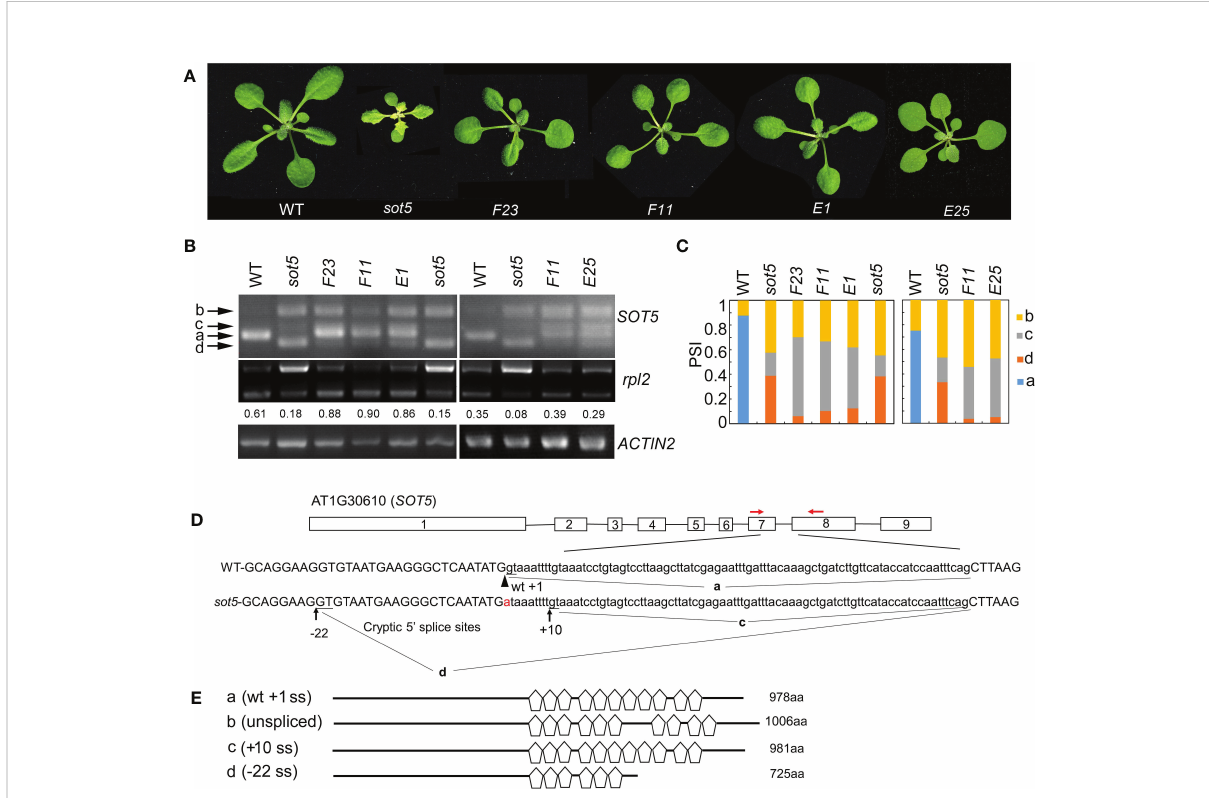
(B) . Red arrows indicate the primers used for RT-PCR. (E) Schematic diagrams of the mutated SOT5 proteins encoded by the variants corresponding to the bands in (B) . Pentagons indicate PPR motifs. The numbers indicate the residue number of each